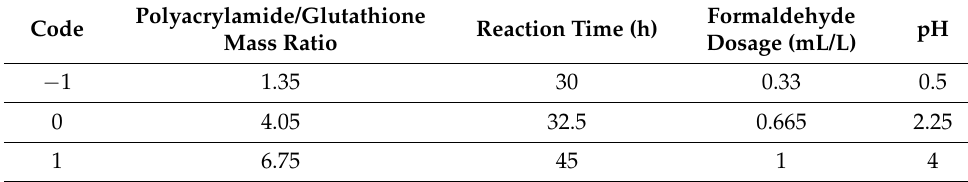
Table 1. The next step in analyzing the response surface model fitting was to enter the corresponding test results for the experimental conditions listed in Table 2. Using the data in Table 2, linear, 2FI, quadratic, and cubic prediction models were developed using the Box–Behnken method’s central composite design principle. The fit (R 2 ), R 2 adj , and R 2 pre analyses of these models are presented in Table 3. Table 1. Experimental factors and level controls.